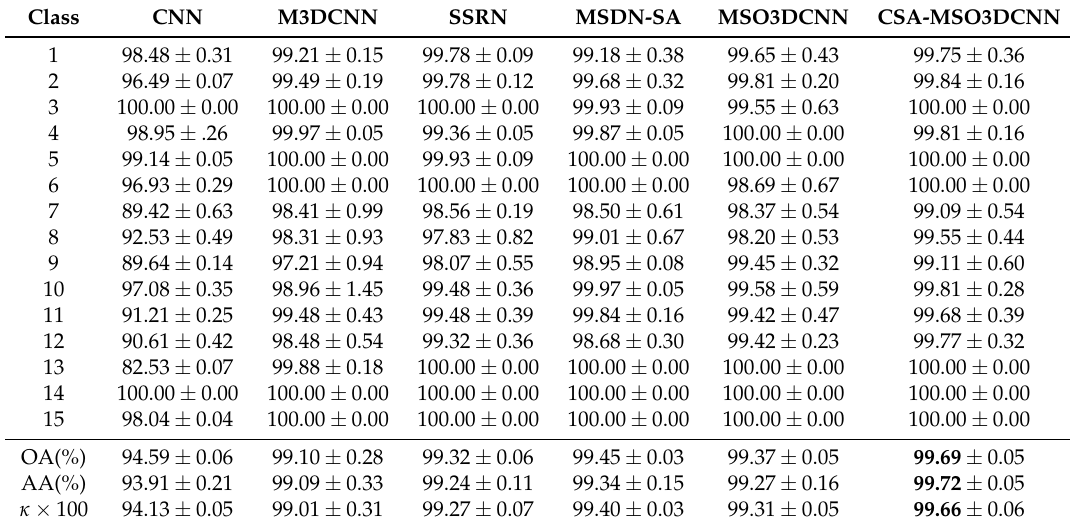
Table 7. Classification accuracy for the Grss_dfc_2013 data set.